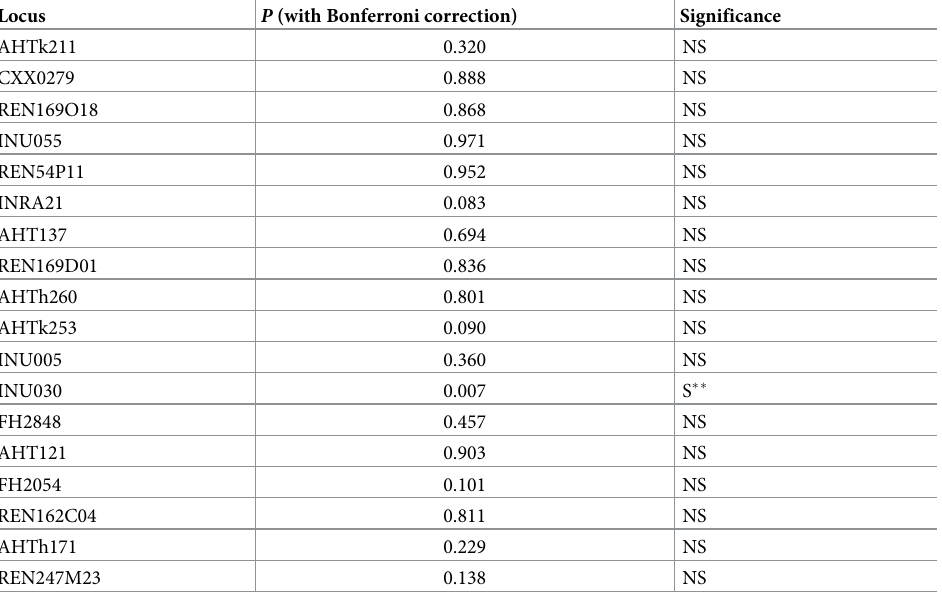
Table 3. HWE for 18 STR markers in total population. Locus P (with Bonferroni correction) Significance